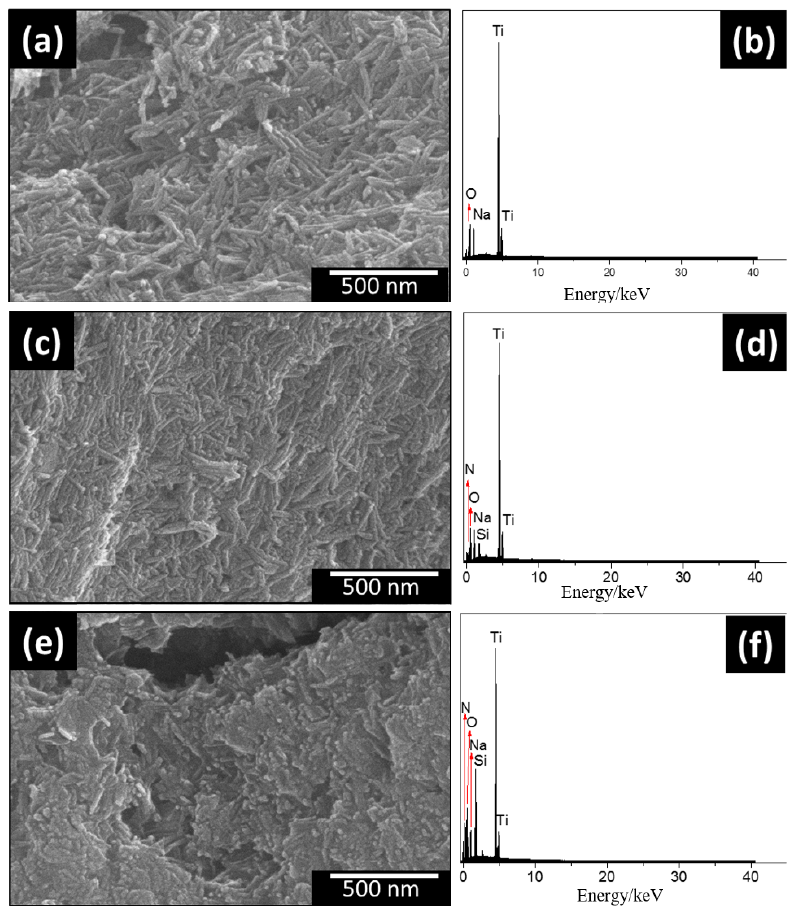
Figure 2. Scanning electron microscopy images and dispersion analysis by X-ray spectroscopy of sodium titanate nanotubes as synthesized. ( a , b ) NaTiNT, ( c , d ) amino-functionalized titanate nanotubes (NaTiNT − 2NH), ( e , f ) NaTiNT −